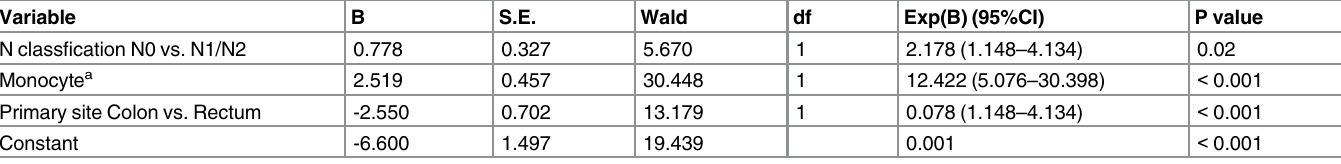
Table 2. Logistic regression analysis of risk factors for liver metastases.